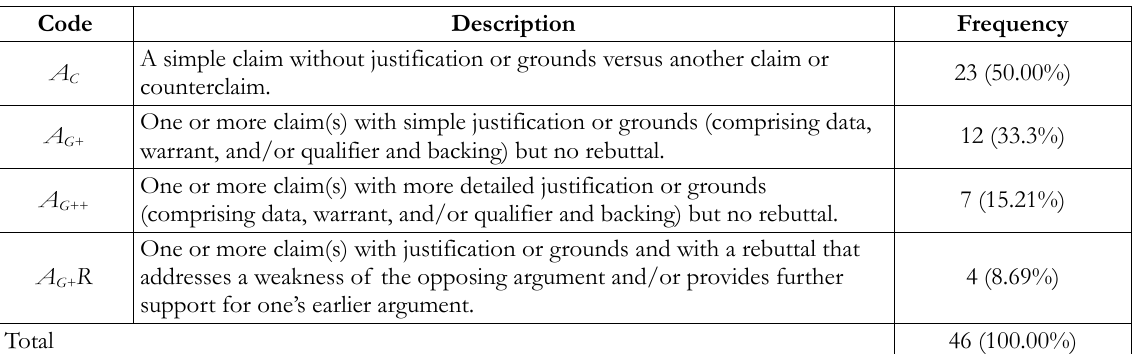
Table 3. Students’ scientific argumentation in the Identification of the social issues